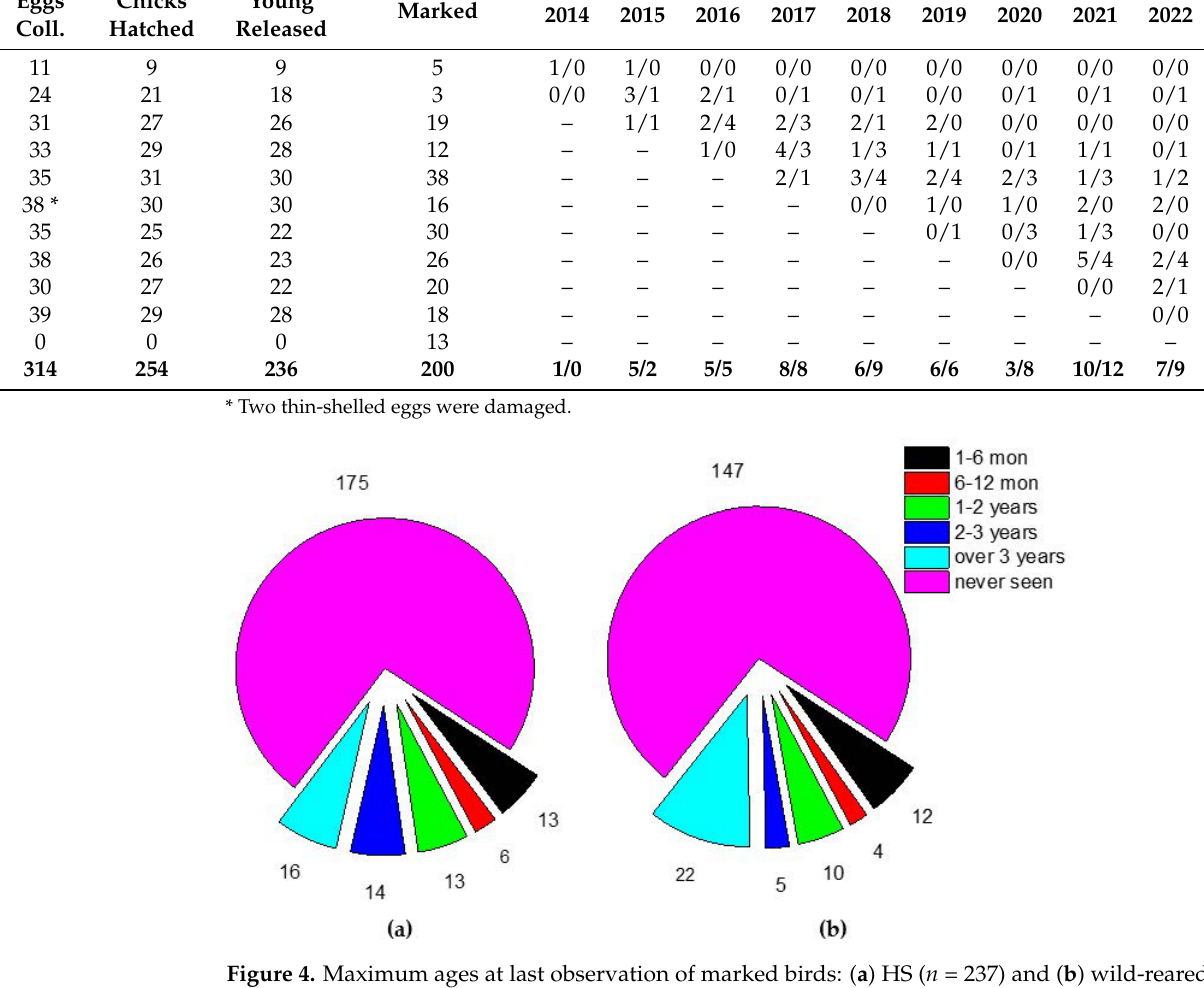
Figure 4. Maximum ages at last observation of marked birds: ( a ) HS ( n = 237) and ( b ) wild-reared ( n = 200)